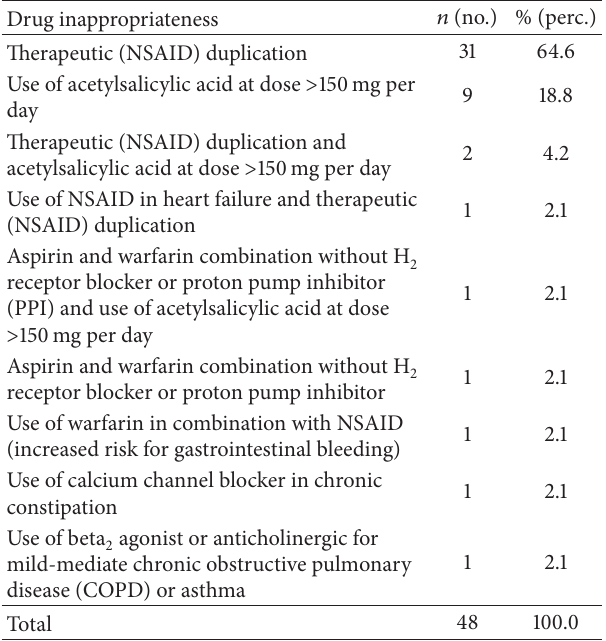
Table 1: Number and percentage of drug inappropriateness accord- ing to STOPP